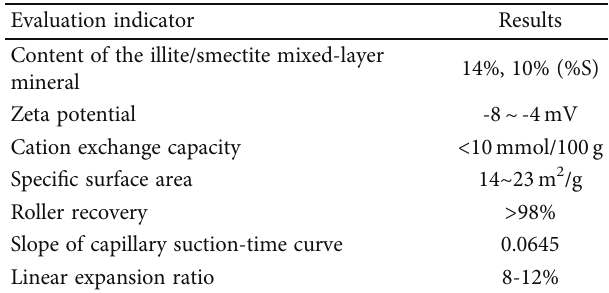
Table 1: Conventional evaluation on the wellbore stability of reservoir